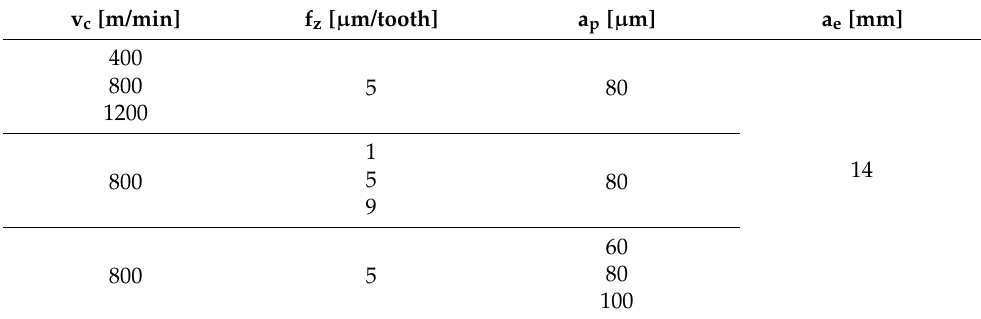
Table 2. Plan of experiments and tested values of technological parameters.